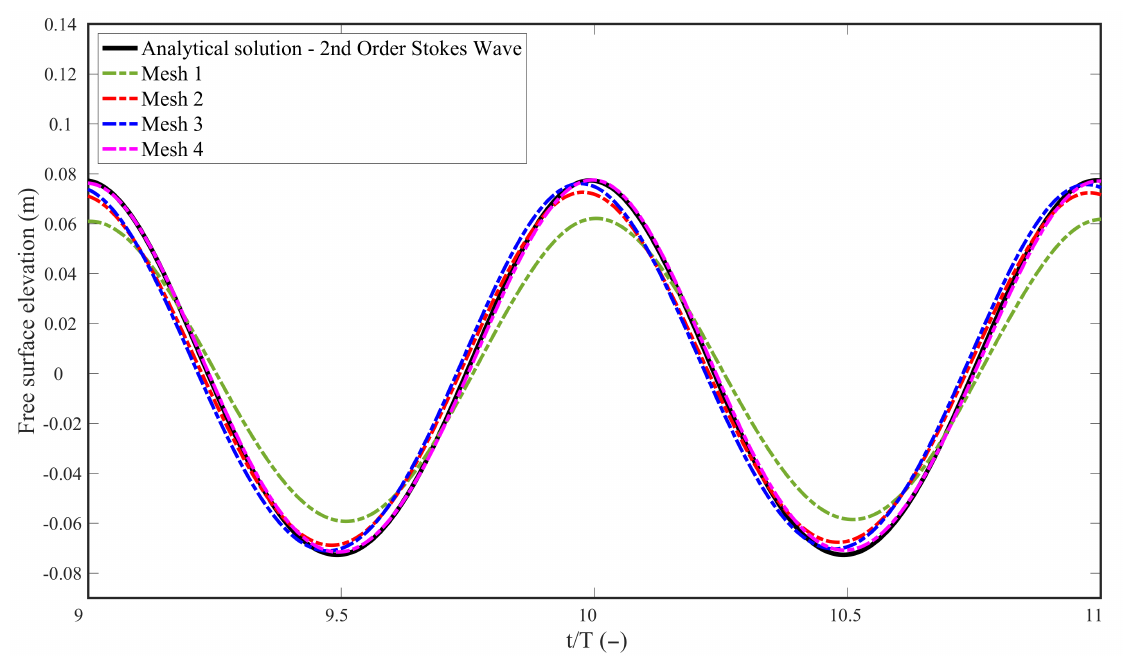
Figure 12. Comparison of mesh discretizations tested in this study.